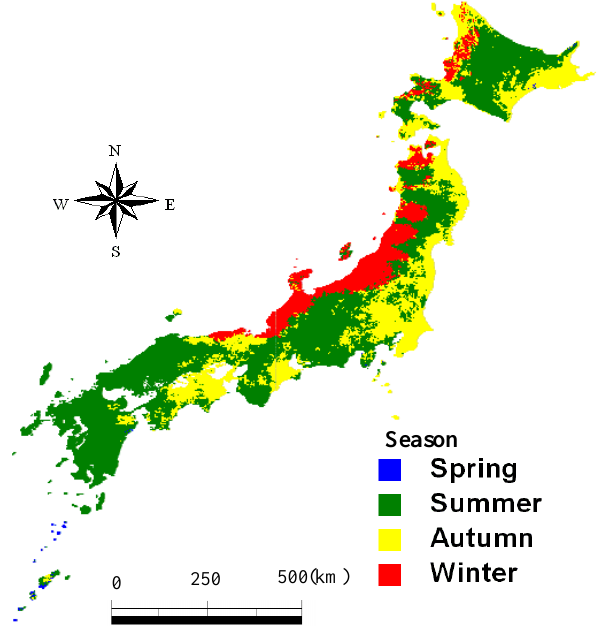
Fig. 2. Distribution of the annual maximum daily